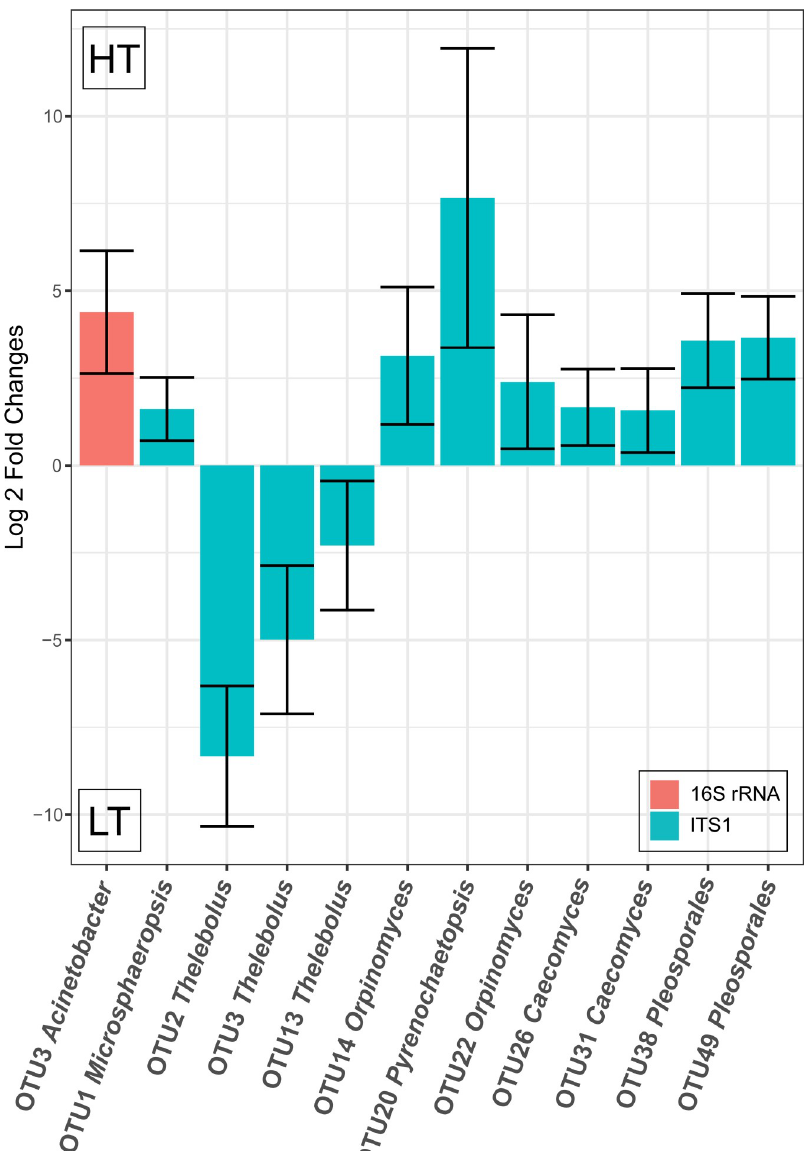
Fig 3. Statistically significantly ( q � 0 . 05 )different abundant bacterial and fungal OTUs considering tolerance group (HT, LT) as an effect. The differences in abundance of OTUs are shown as log2 fold changes for each tolerance group. Positive values represent higher abundance in HT cattle, negative values represent higher abundance in LT cattle. Error bars represent the 95% confidence